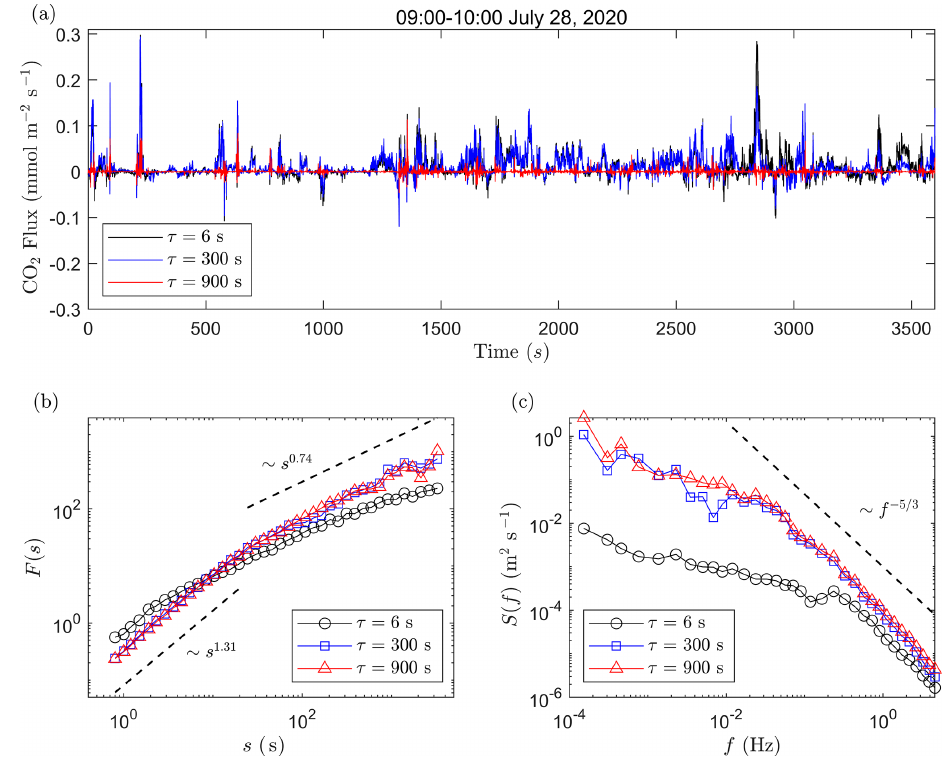
Figure 3. The intrinsic non-stationarity in the 1h time series of carbon dioxide turbulent fluxes. (a) The 1h time series of instantaneous turbulent fluxes of carbon dioxide with the Reynolds average time τ = 900, 300, and 6s. (b) The detrended fluctuation analysis of these time series. For comparison, the time series are normalized to zero mean and unit variance. The power functions with the fitted fluctuation exponents are shown by the broken lines. (c) The power spectral densities of these time series. The Kolmogorov − 5 / 3 law is shown by the broken